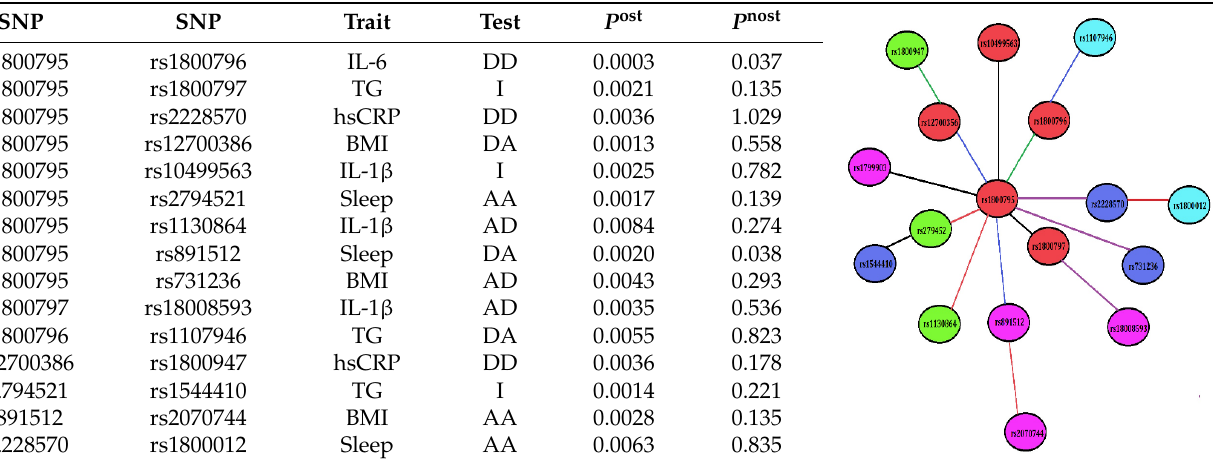
Many SNP–SNP interactions were deduced between osteoarthritis and non-osteoarthritis subjects, but only significant effects are shown here. P ost : p values showing the gene–gene effect (SNP × SNP) influencing risk variables in osteoarthritis patients ( n = 279), P nost : p values showing the gene–gene effect (SNP × SNP) influencing risk variables in non-osteoarthritis subjects ( n = 287).Two-locus effects of these SNP pairs indicate AA: additive x additive (Red line color),AD: additive x dominant (Purple line color), DA: dominant x additive (Blue line color), DD: dominant x dominant (Green line color), and I: interactive effect (Black line color). Lines between SNPs indicate pairwise epistasis effect. Colors of the ellipse indicate Red: IL-6 gene, Green: CRP gene, Cyan: COL1A1 gene, Blue: VDR gene, and Magenta: eNOS gene. IL-6: interleukin-6, IL-1 β : interleukin 1-beta, hsCRP: high sensitivity C-reactive protein, LDL: low density lipoprotein, TG: triglyceride, BMI: body mass index.